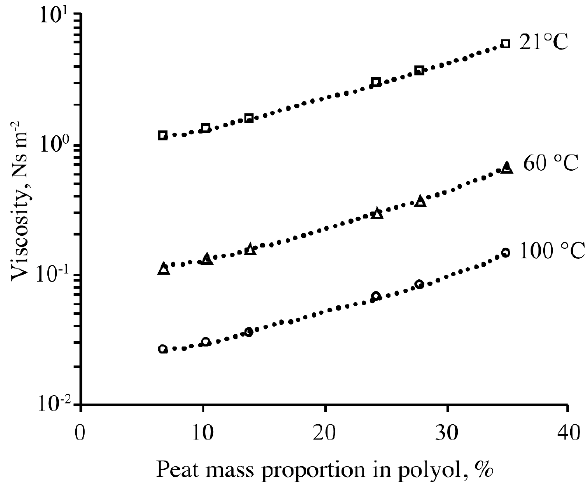
Figure 3. Viscosity of the mixture of H6 filler and castor oil at three